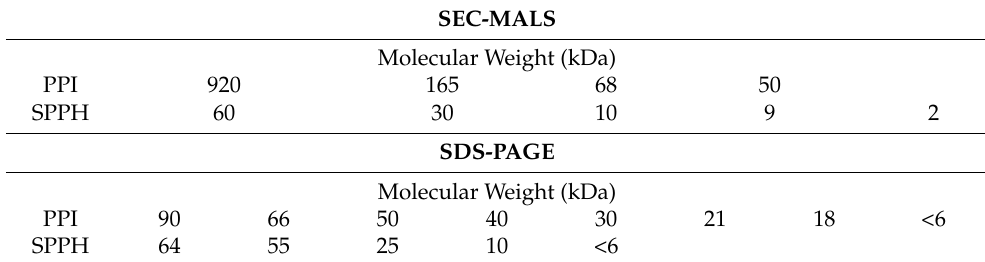
Table 1. Molecular weight distribution of PPI and